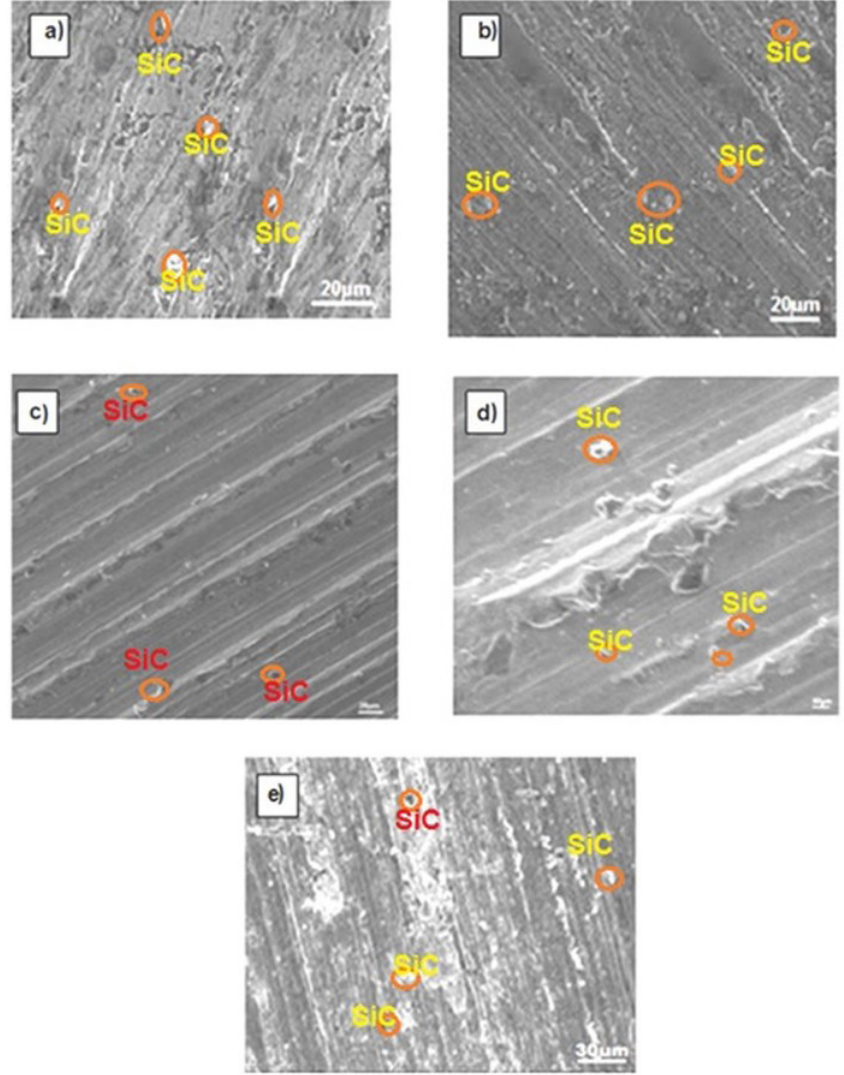
Figure 5. SEM images of different worn surfaces (a) 25N of Load, 400 rpm of disc speed, 9m/s of velocity and wear rate of 0.0587 mm 3 /min(b) 20N of Load, 800 rpm of disc speed, 9 m/s of velocity and wear rate of 0.0534 mm 3 /min (c)15N of Load, 400 rpm of disc speed, 3 m/s of velocity and wear rate of 0.01355 mm 3 /min (d) 20N of Load, 400 rpm of disc speed, 6 m/s of velocity and wear rate of 0.0486 mm 3 /min (e) 25N of Load, 1200 rpm of disc speed, 6 m/s of velocity and wear rate of 0.0893 mm 3